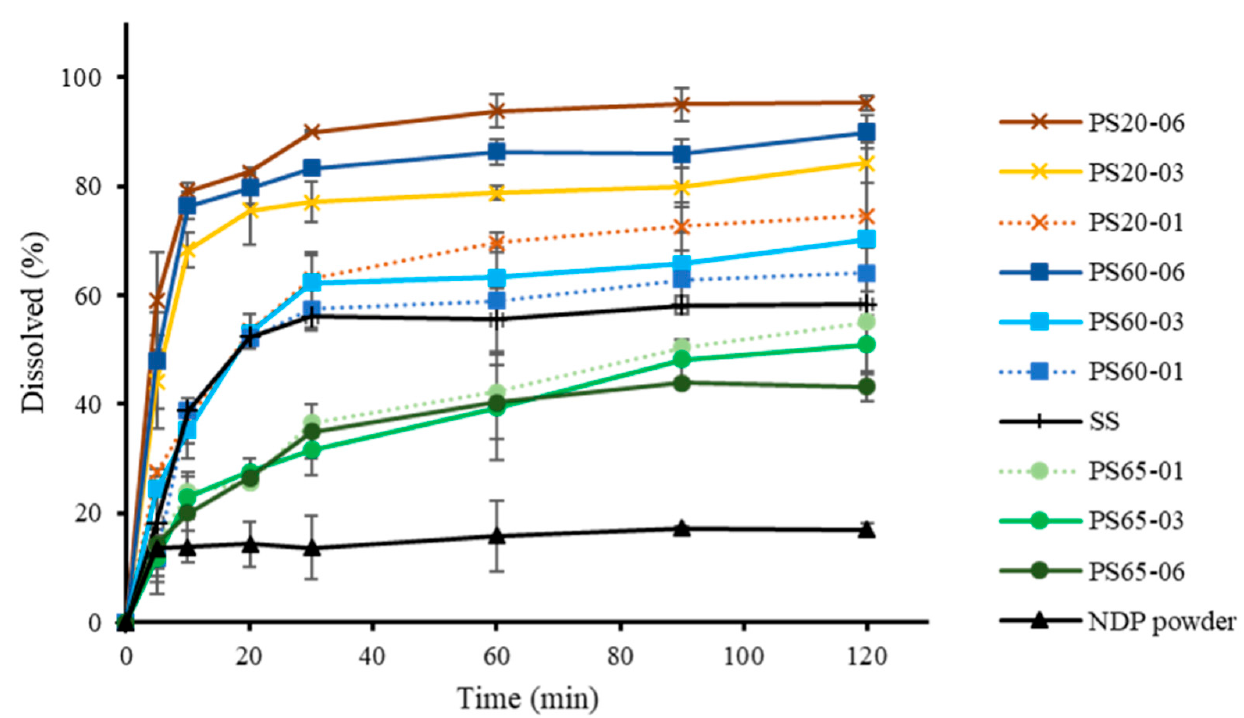
Figure 5. Dissolution profiles of nifedipine powder and solid solutions (error bars indicate standard deviation; n = 3). Table 3. Percentages of NDP dissolved after 20 (Q20) and 120 (Q120) min.